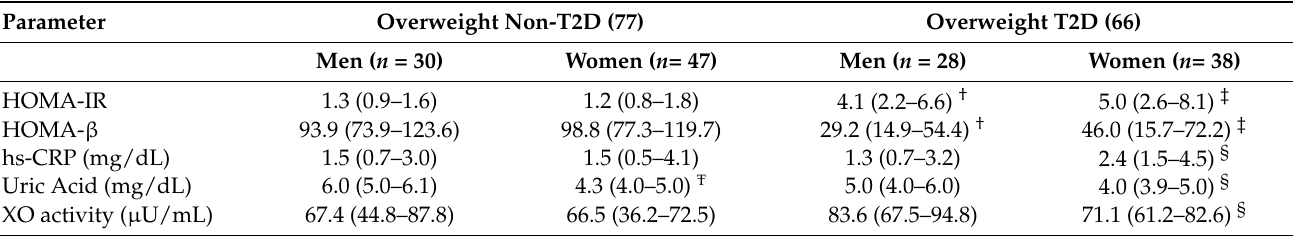
Table 2. Cont. Table 2. Sex-based analyses of overweight T2D patients and non-T2D subjects.